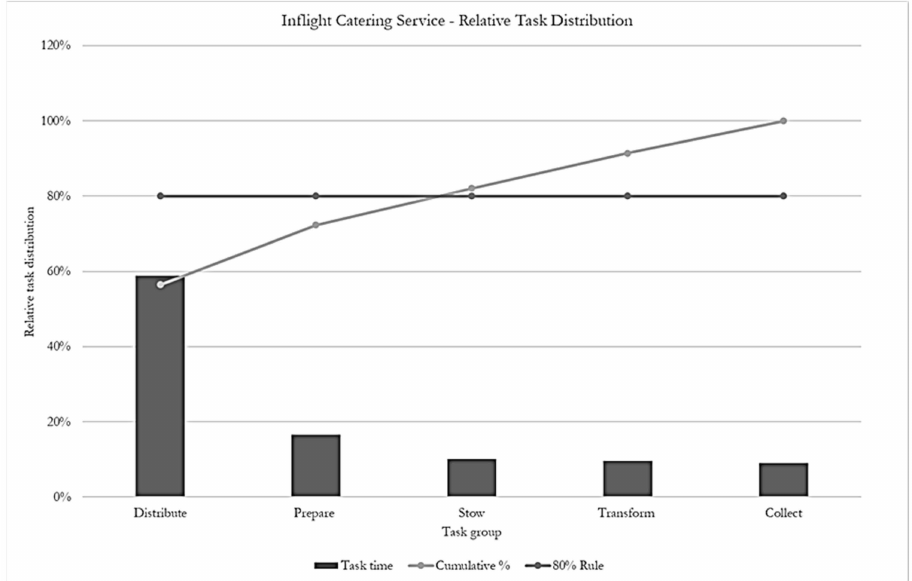
Figure 12. Example task distribution of a full-service, long-haul flight with a lunch